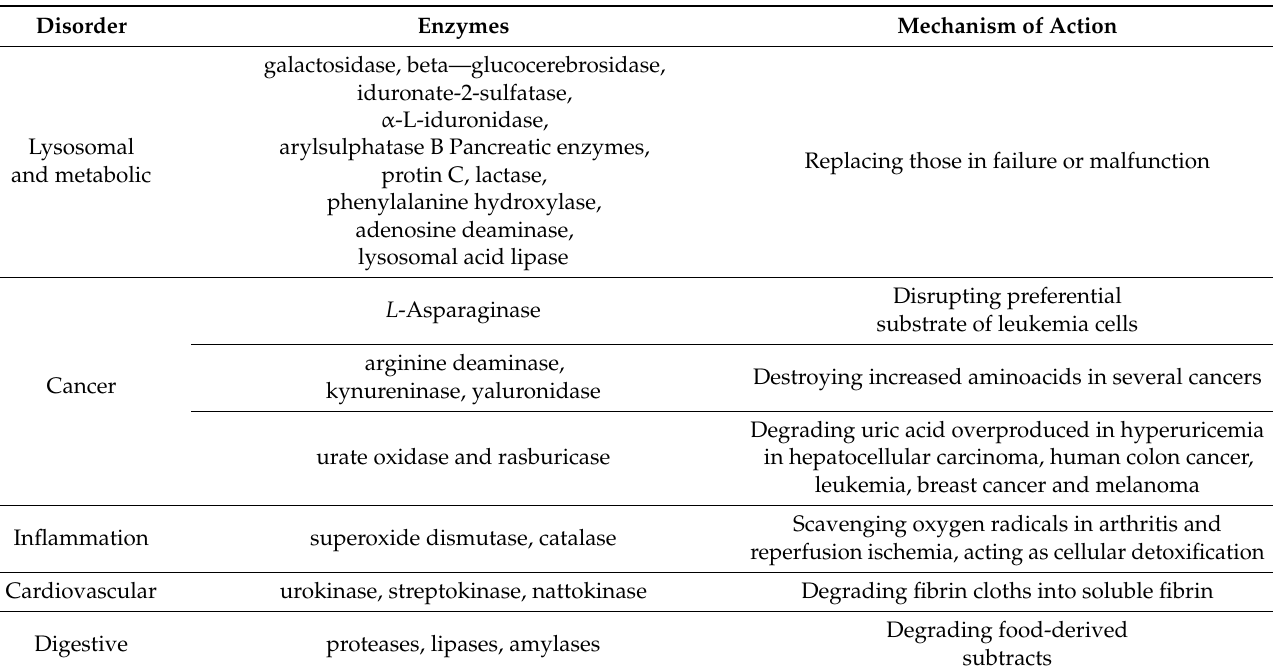
Table 1. Examples of enzyme applications against selected diseases. Adapted from de la Fuente et al. [12] and Kumari et al. [26].